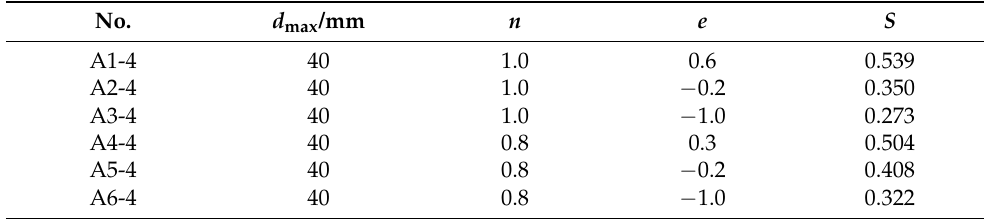
Table 1. Details of grading parameters and grading area of soil